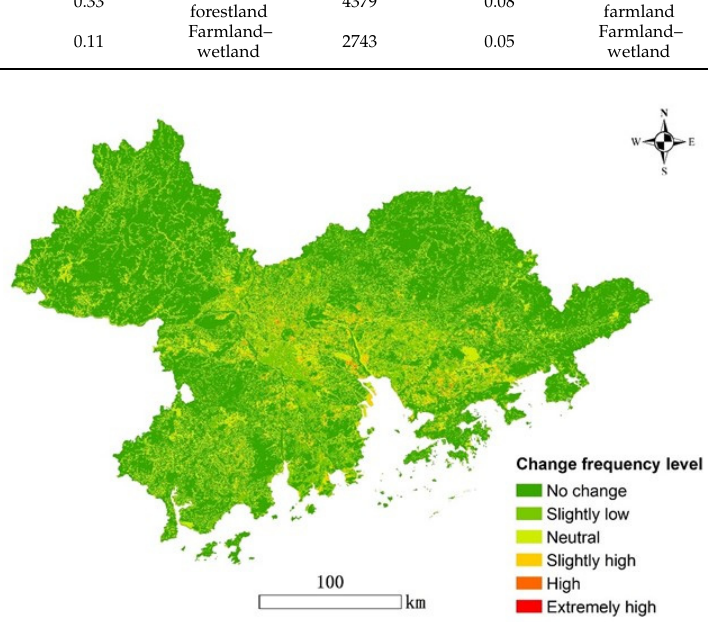
Figure 4. Spatial distribution of land-use-change frequency. Table 4. Proportion of area in areas with different frequencies of land-use